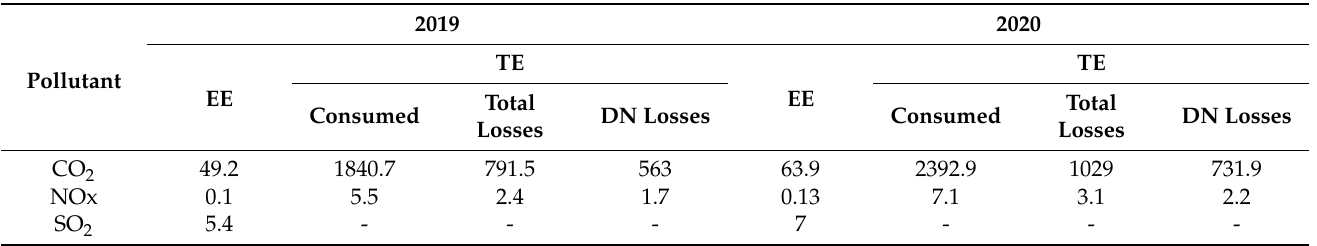
Table 14. Pollutants estimated to be released in the energy production process (TE—from the municipality district heating network) [tons].